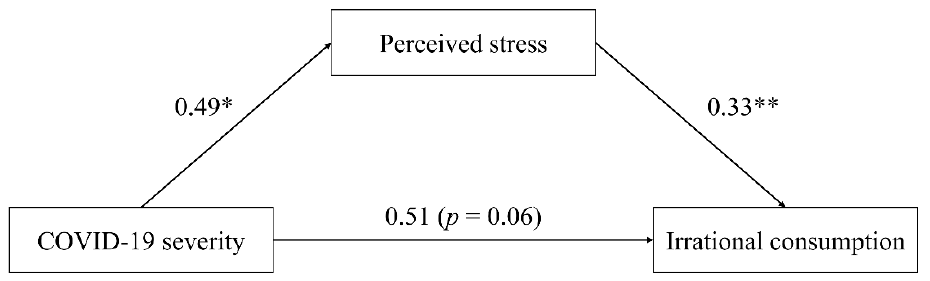
Figure 2. Mediation analysis: perceived stress as a mediator (Study 1). * represents significance at the 0.05 level; ** represents significance at the 0.01 level.